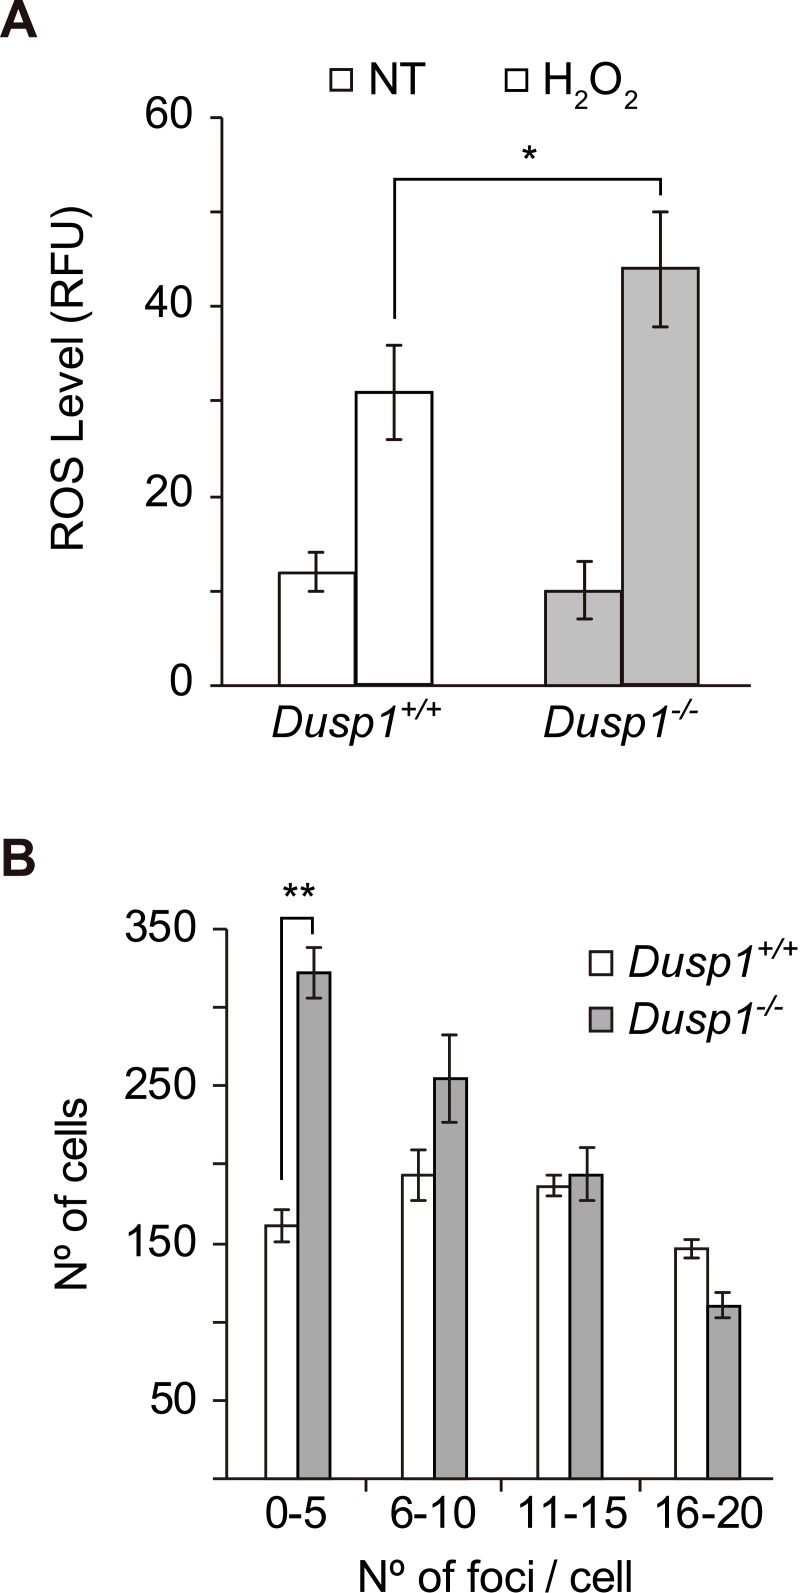
Production of reactive oxygen species and DNA damage in MEF cells.(A) Dusp1+/+ (white) and Dusp1–/– (gray) MEF cells were treated with H2O2 (200 µM) for 30 min. The results for non-treated control cells are also shown for comparison (NT). After harvesting the cells, the emission of dihydroethidium (DHE) was analyzed by flow cytometry. (B) Detection of DNA damage in MEFs cells. DNA damage was determined by immunocytochemistry with a γ-H2A.X antibody and the staining of nuclei with DAPI. Quantification of γ-H2A.X foci per cell is described in 'Materials and methods'. In each case, more than 200 cells were analyzed. Statistically significant differences were analyzed by two-way ANOVA (*p<0.05 and **p<0.01).